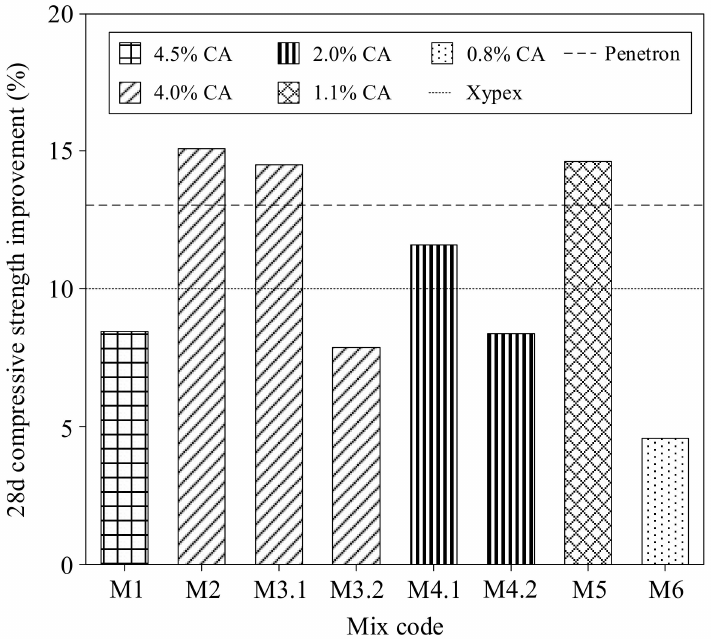
Figure 7. Concrete strength increments due to the addition of CA at 28 days; data are taken from available literatures and the details of mix code can be seen in Table 3. The dot and dash-dot lines represent the value of compressive strength enhancement by using Xypex Admix (2–3% CA) and Penetron CA (0.8–1% CA), respectively, according to the technical data sheets